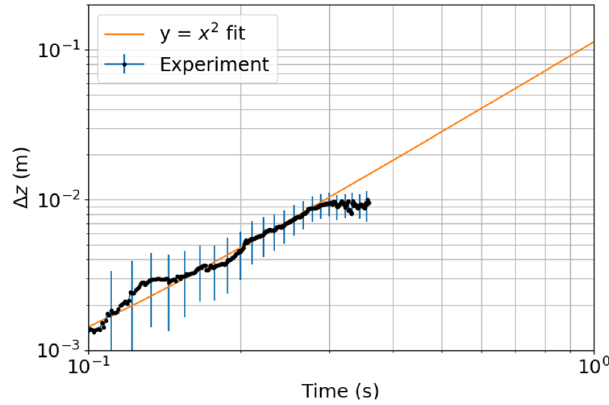
Fig. 8. Relative sinking ∆ z as a function of time for a beaker dropped from the height of 66 cm. The contact angle is θ = 63 o